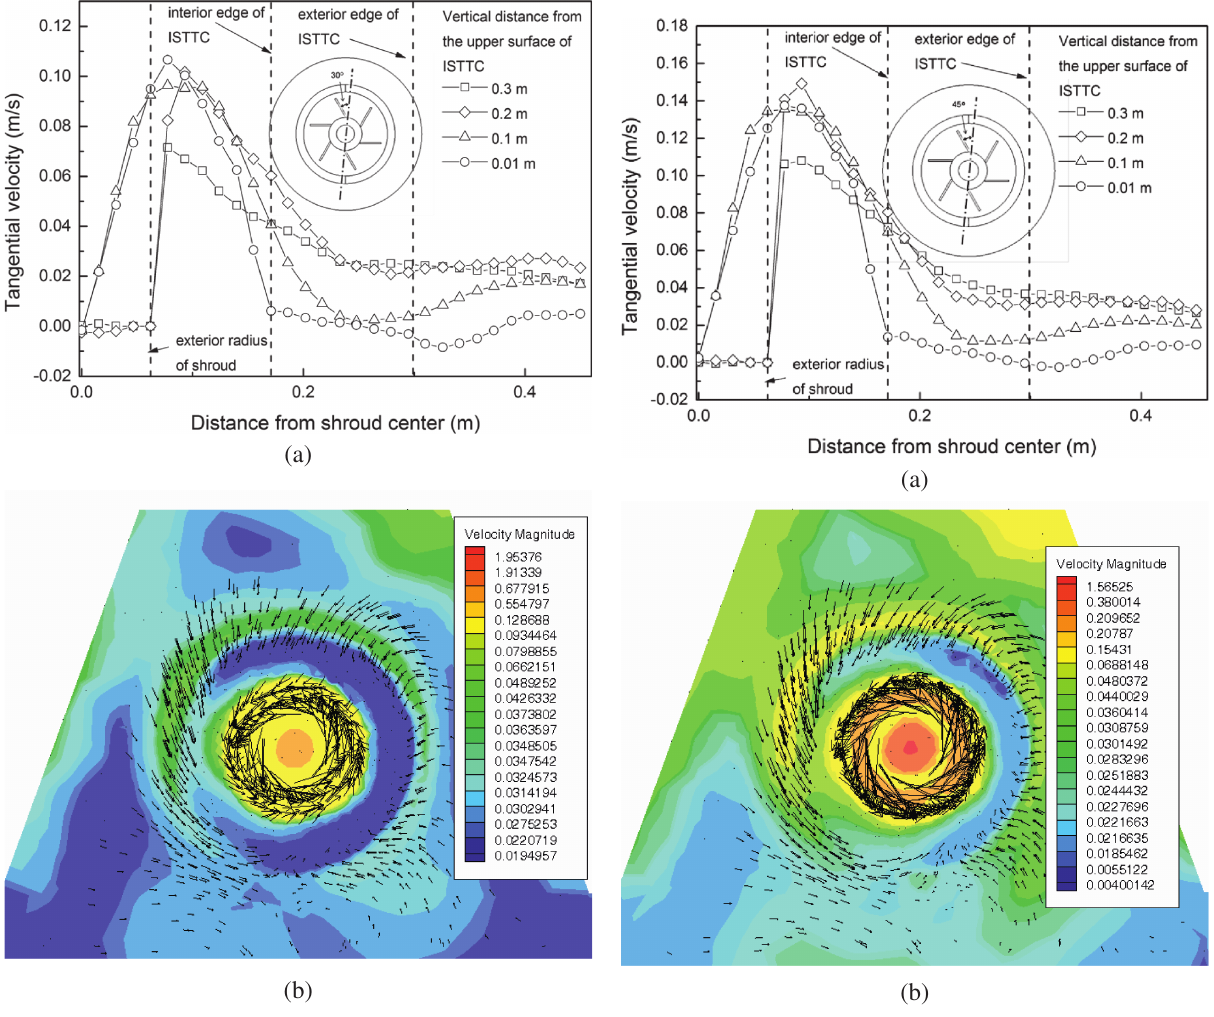
Figure 10: The tangential velocity distribution of zone above ISTTC with θ of 30°. (a) The tangential velocity distribution (b) The vector diagram of plane (h pl = 0.01m).